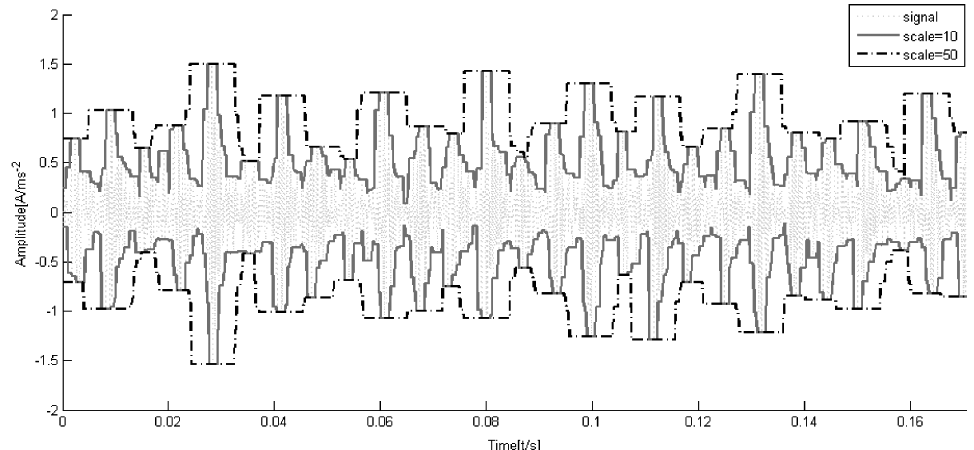
Fig. 3. Signal from outer race severe defect and its dilation and erosion by rg at scale 10 and 50 (the solid line corresponding to scale 10, the dashed line corresponding to scale 50).